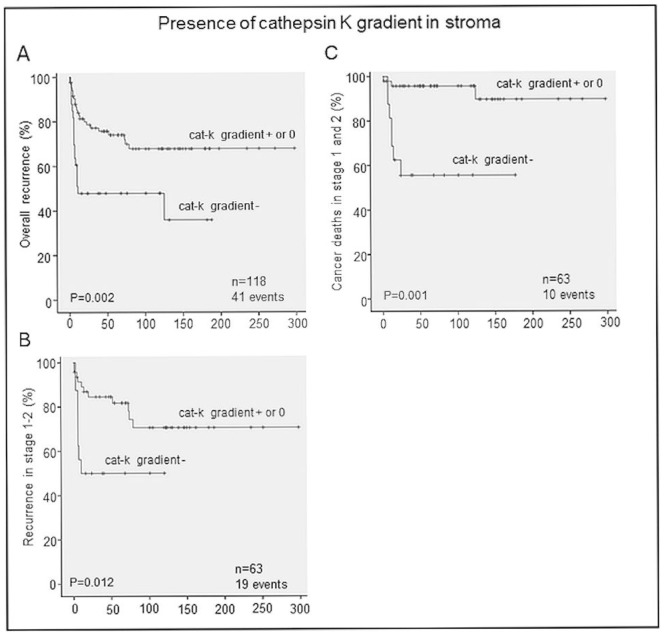
Weaker staining of cathepsin K in the invasive front correlates with shorter recurrence-free survival and increased mortality.Survival analyses show a shorter overall recurrence-free interval in patients with a lower cathepsin K staining gradient (cat-K gradient −) compared with those with either higher (cat-K gradient +) or no gradient (gradient 0) of cathepsin K staining intensities in the invasive front compared with the upper part of the tumor (A), especially seen in patients with stage 1 or 2 OTSCC (B). Disease-specific survival of patients with stages 1 and 2 OTSCC tumors was better in patients with a positive or no gradient of cathepsin K staining compared with those with a negative gradient (C).